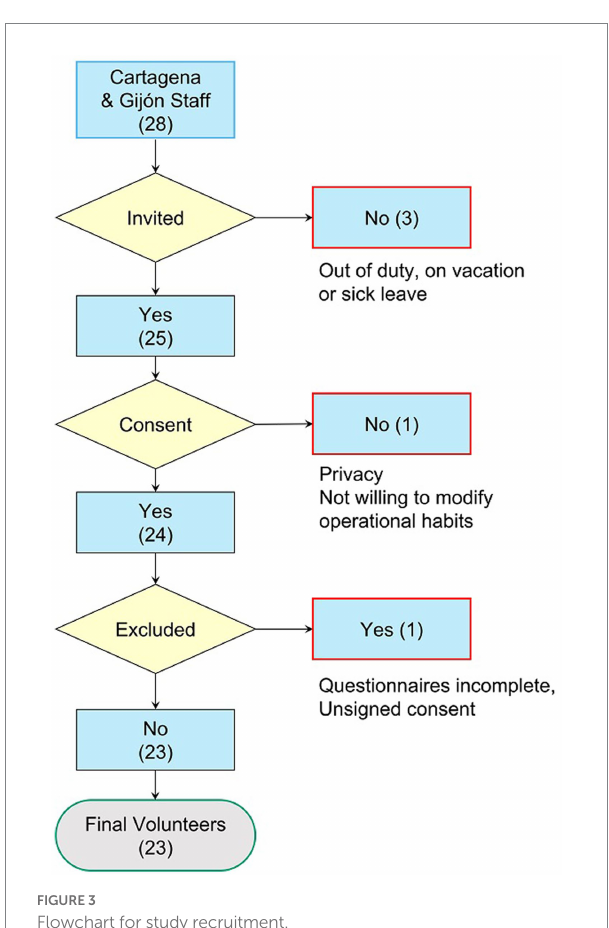
FIGURE 3 Flowchart for study recruitment.